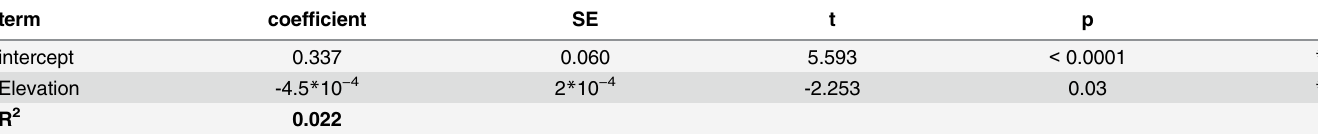
Table 4. Final regression model of drought impact patch shape as a function of